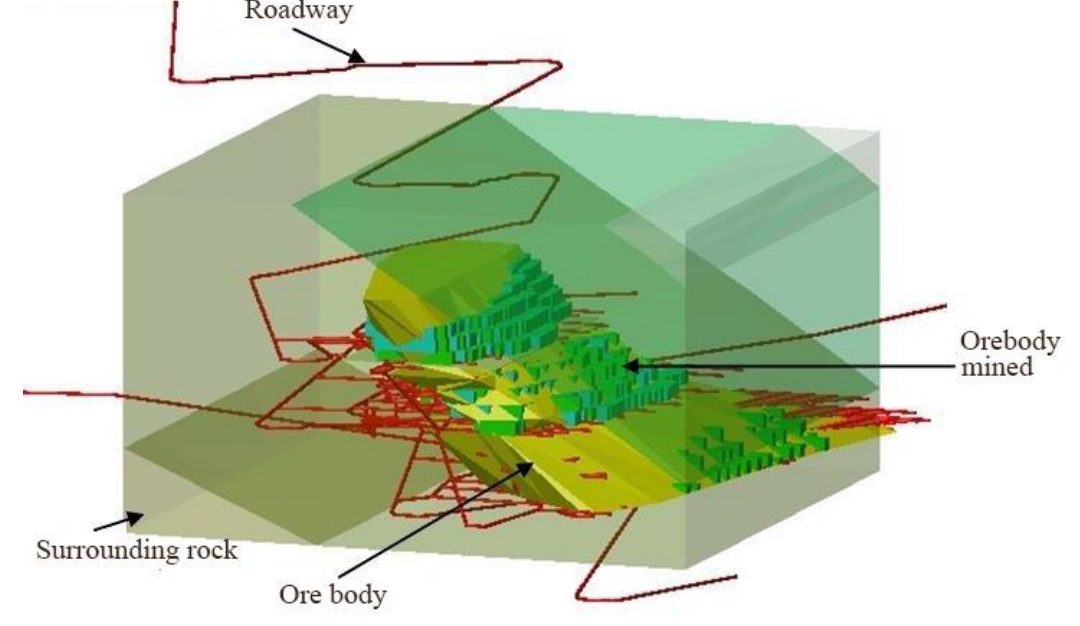
Figure 1. 3D view of the V# ore body.